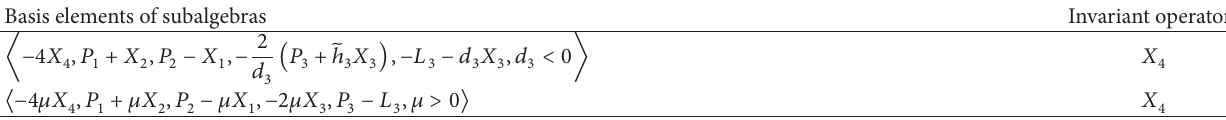
Table 27: Invariant operators of subalgebras of the type 𝐴 𝑝𝜀 5,26 (𝑝 = 0, 𝜀 = −1) . Basis elements of